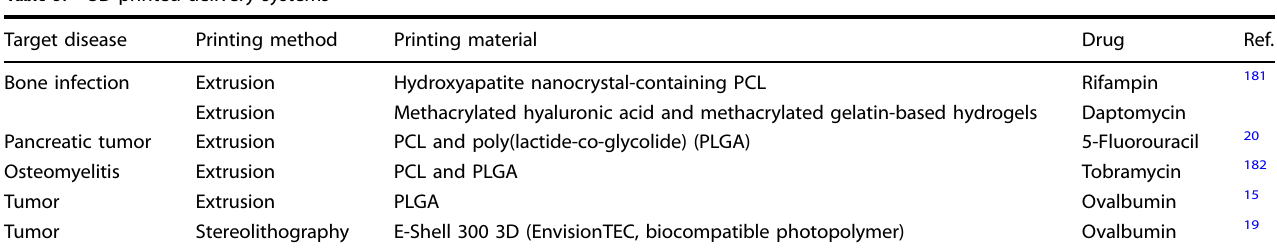
Table 3. 3D-printed delivery